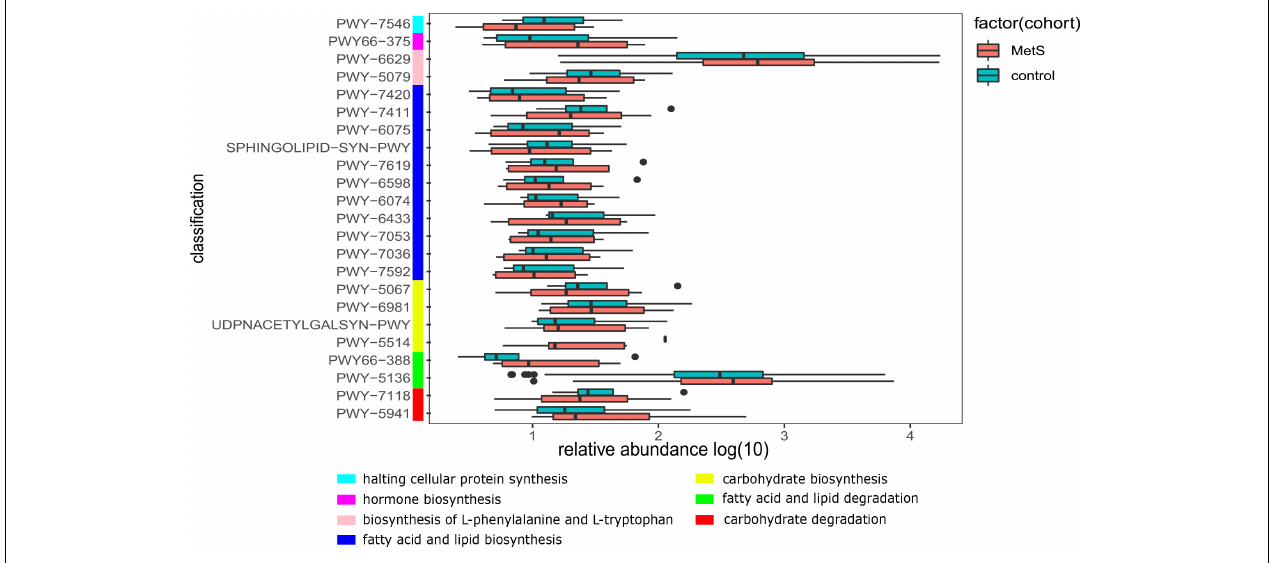
FIGURE 5 | The functional shifts of bacterial species between the MetS and control groups. We found that 64 pathways were significantly different, and 57 pathways were enriched in MetS subjects. p < 0.05. Within the 57 MetS-enriched pathways, we showed the 23 pathways that were responsible for metabolism of carbohydrates, fatty acids, lipids, amino acid, hormones, and halting cellular protein